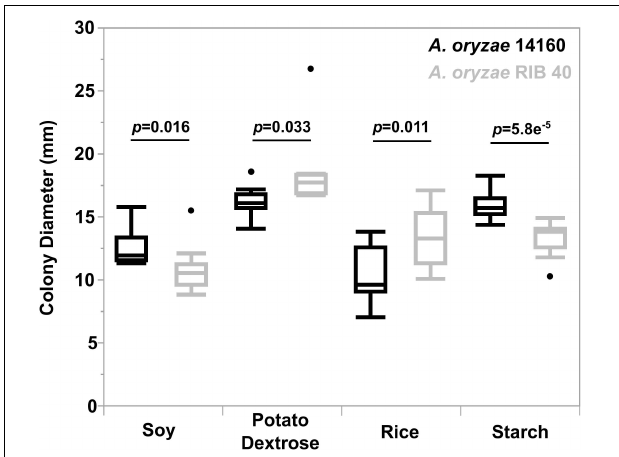
FIGURE 6 | Growth characteristics of A. oryzae 14160 and RIB 40 in various media. The Y-axis represents colony growth, while the X-axis represents culture media. Points outside of the boxplots represent outliers. Black and gray boxes represent A . oryzae 14160 and RIB 40, respectively. T -test p -values are provided for each culture